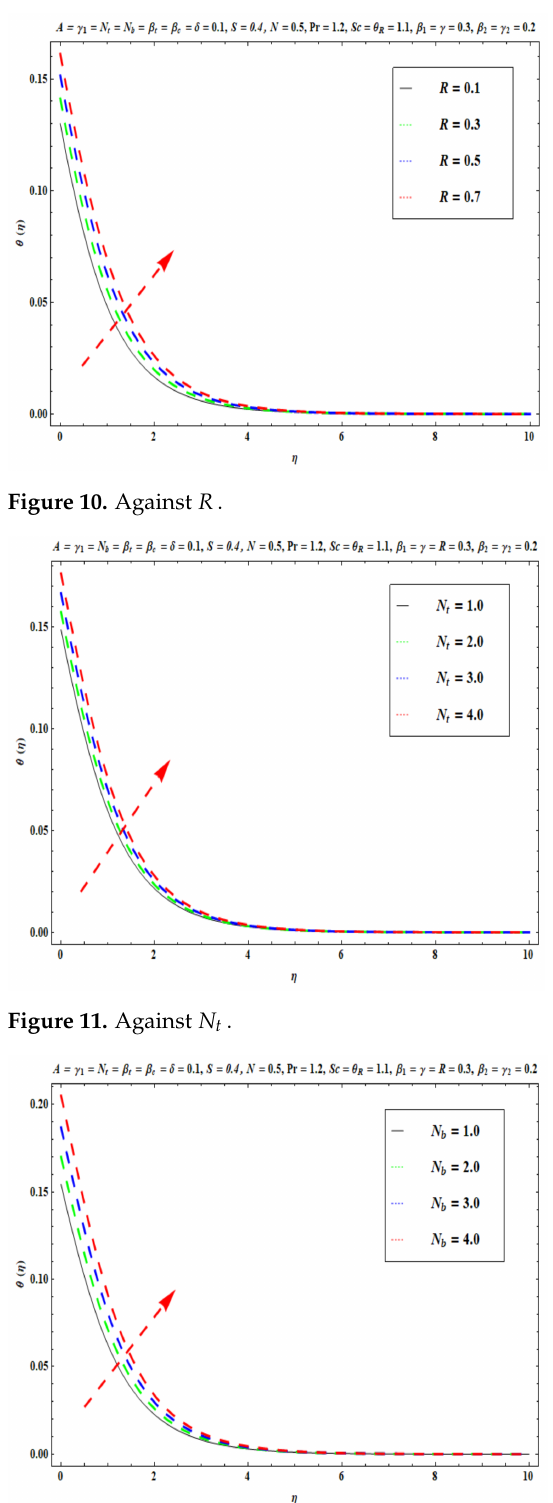
Figure 12. Against N b